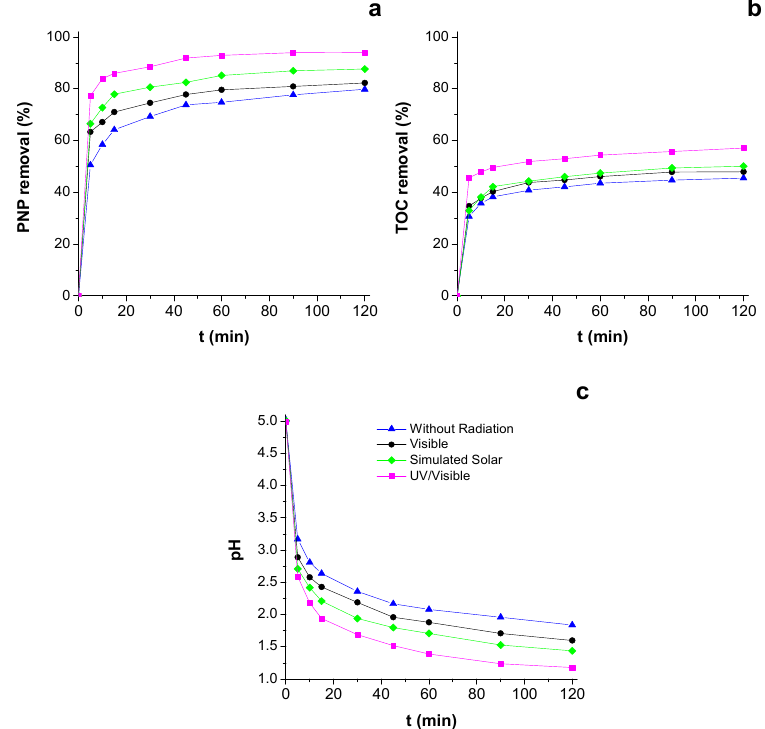
Figure 5. PNP ( a ) and TOC ( b ) removals and pH evolution ( c ) during the persulphate oxidation process when using different types of light ([PNP] o = 500 mg/L, pH = 5.0, T = 70 ◦ C, I = 449 W/m 2 and [S 2 O 82 − ] o = 6.4 g/L).